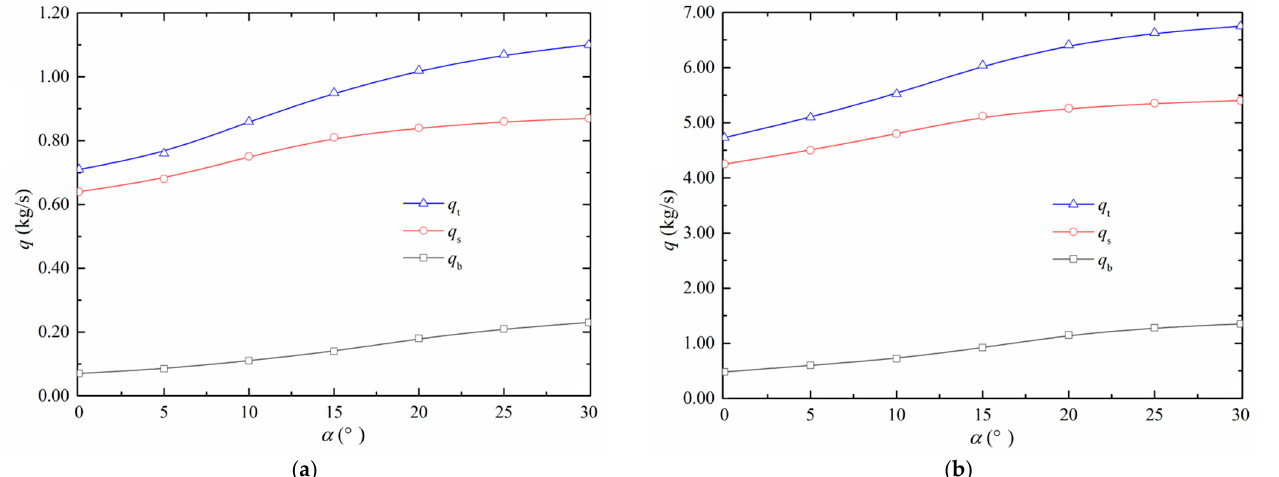
Figure 17. Bypassed sediment flux through the sluice gates. ( a ) case 1; ( b ) case 2. The dominating portion of sediment is suspended load.